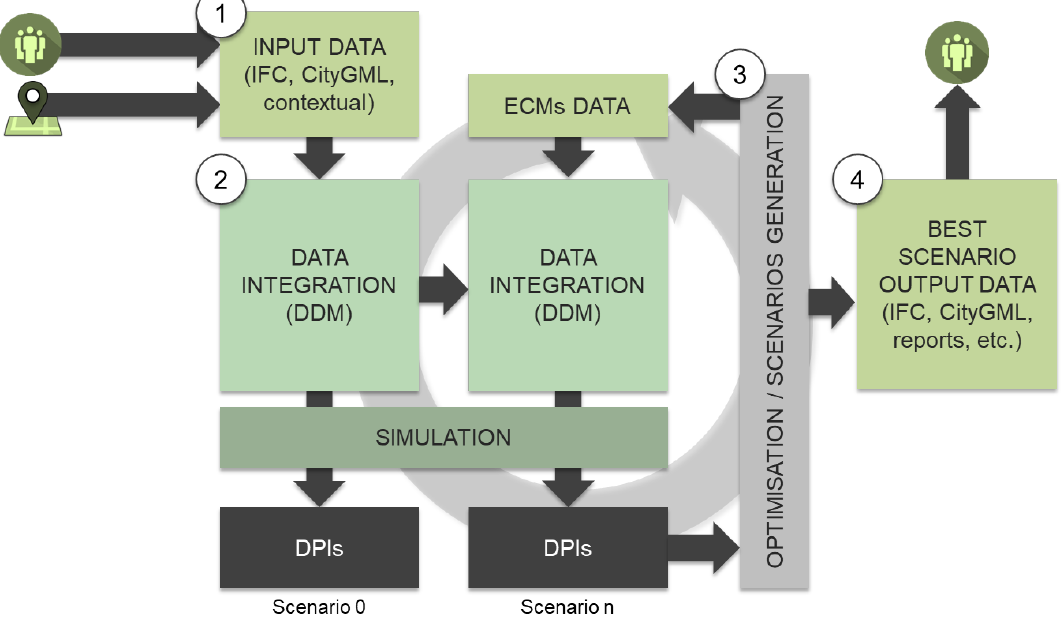
Figure 1. Platform process. Adapted from [16].